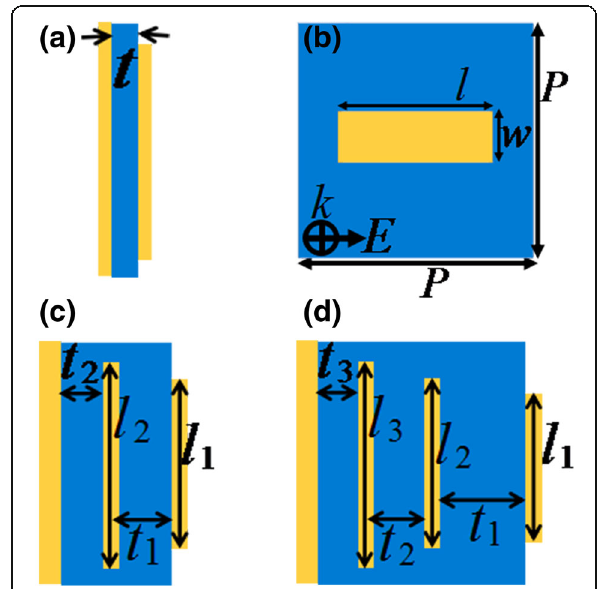
Fig. 1 Side views of the single-band, dual-band, and triple-band MPAs are respectively presented in a , c , and d ; b gives the top view of the Au strip